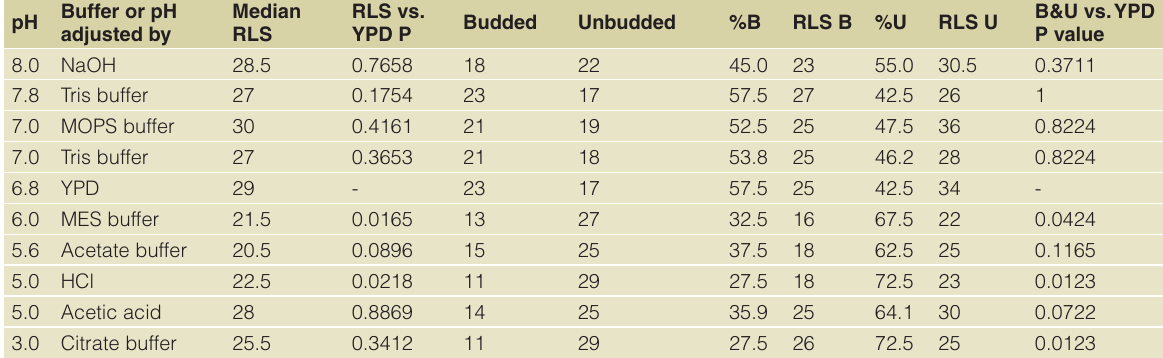
Table 1. Effects of pH and buffering on terminal morphology and statistical analysis for experimentally matched RLS data shown in Figure 1 . Buffer or pH pH adjusted